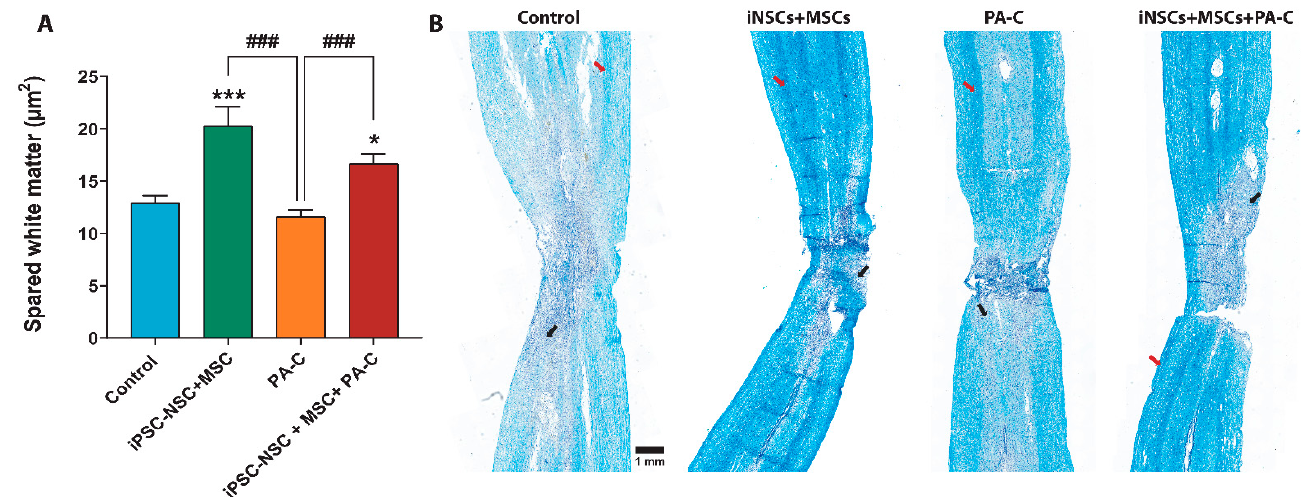
Figure 7. PA-C combined with iPSC-NSC + MSC transplantation increases white matter sparing. ( A ). White matter sparing analysis expressed as mean ± S.E.M determined by one-way ANOVA with Tukey’s multiple comparison test (n = 3). * p < 0.05, *** p < 0.001 vs. control; ### p < 0.001 as indicated. ( B ). Representative images of spinal cord longitudinal sections (right panel; scale bar = 1 mm); Black arrows and red arrows indicate demyelinated areas and myelinated areas, respec- tively.